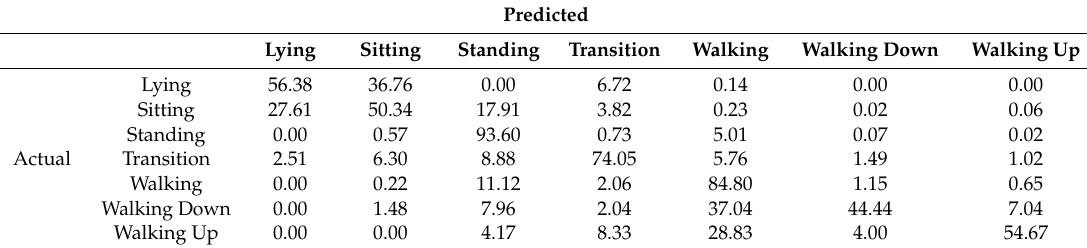
Table A6. Confusion matrix for the 1D CNN (in percentages, averaged over 10 runs).